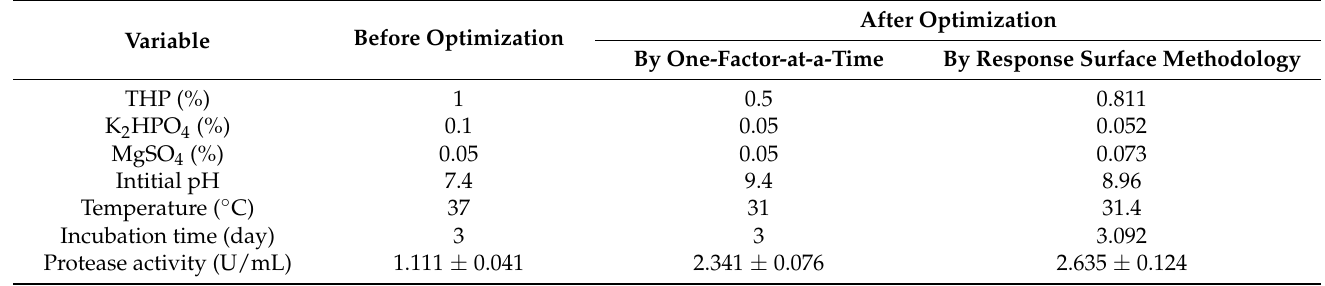
Table 3. Comparison of P. elgii TKU051 (cid:48) s protease production on different culture